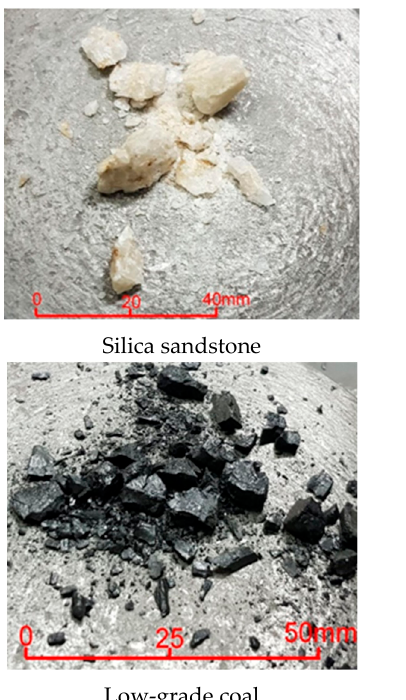
Figure 4. ( a ) Picture of the drop weight tester, ( b ) with illustration to highlight its main features.